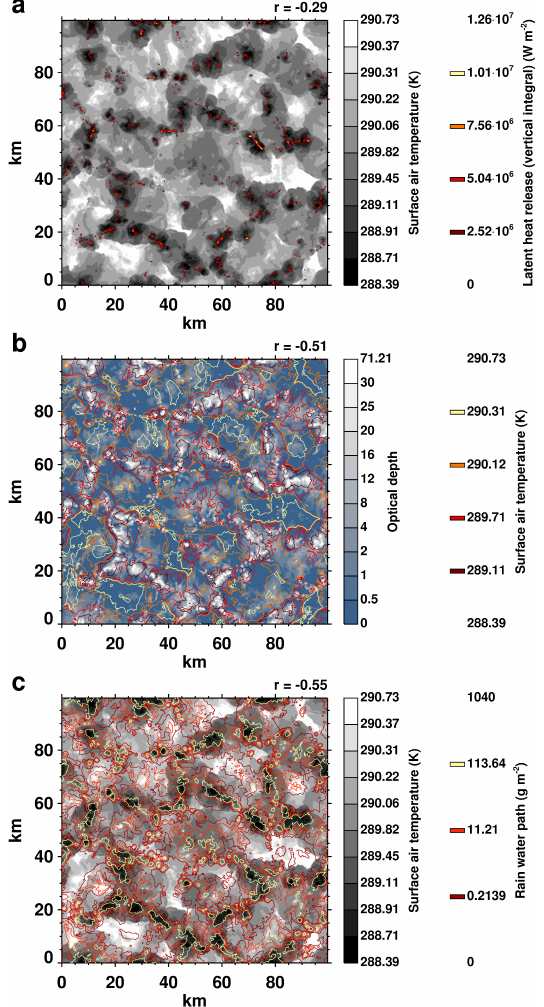
Fig. 11. Latent heat release path (a) , cloud optical depth (b) , and rain water path (c) with surface air temperature in simulation S ◦ . Surface air temperature is shown after 26h, the latent heat release path 40min, cloud optical depth 30min, and rain water path 20min earlier. Correlation coefficients of the data at these lags are given. Ir- regular contour intervals (at select percentiles of the data) are used for better visualization. Color scales are bounded by minima and maxima of the data. Minimum and maximum line contours are sup- pressed. The corresponding spatially filtered data are shown in the Supplement, Fig.